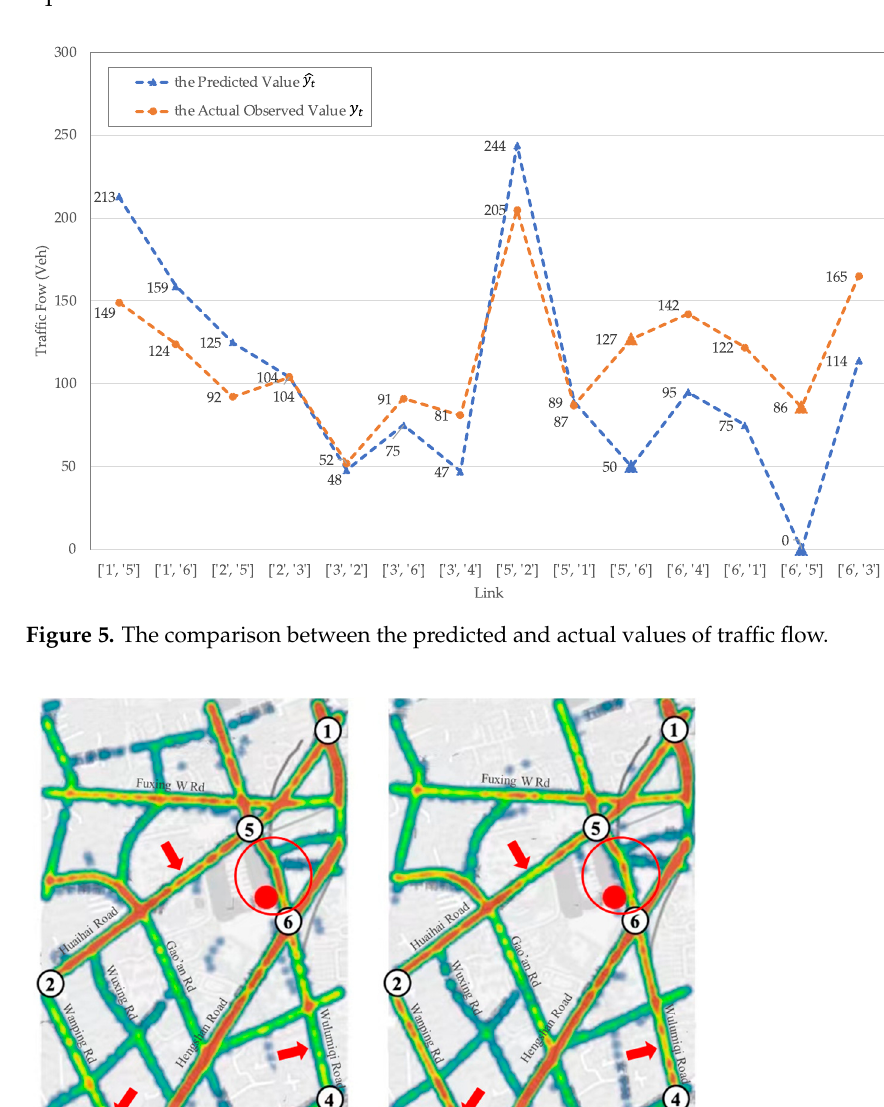
Table 4. Prediction performances of the dynamic traffic assignment model.